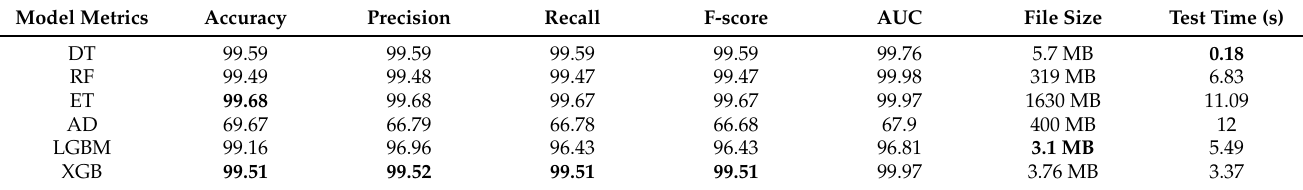
Table 7. Performance evaluation of the trained models on the CIC-IDS2017 dataset showing the time for prediction and model